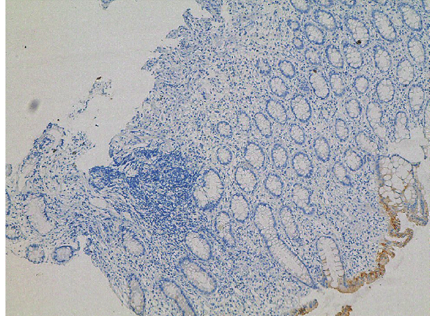
Figure 4: IHC staining of rectal biopsy taken during